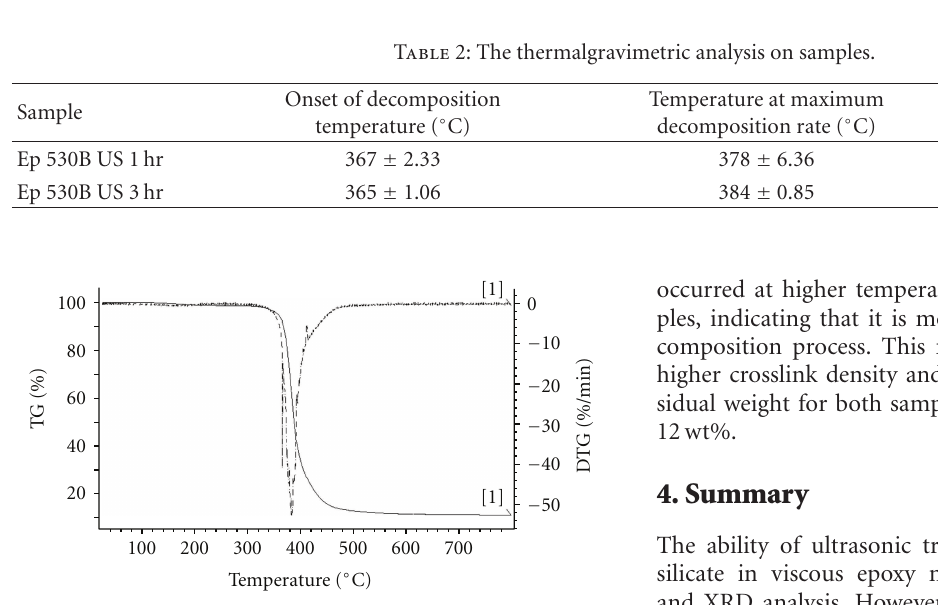
Figure 4: TG and DTG of epoxy clay nanocomposite prepared by mechanical stirring and ultrasonic treatment of 1-hour duration.